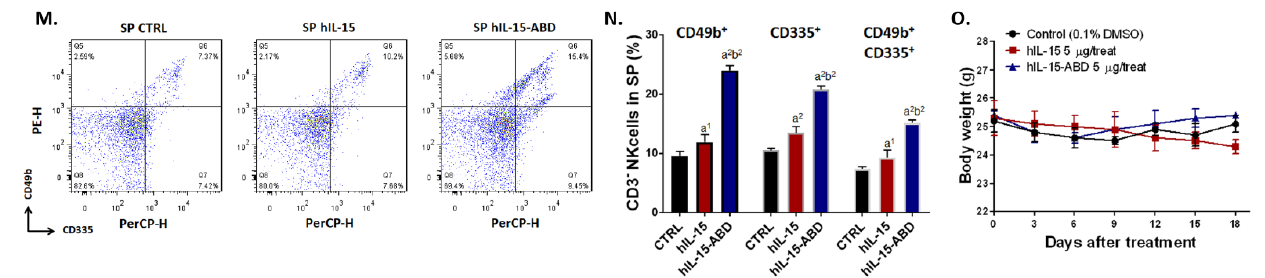
Figure 3. hIL15-ABD induced the accumulation of CD8 + T cells and NK cells, but diminished Tregs and MDSCs, resulting in colon cancer growth inhibition. ( A ) Animal flow chart of different treatment materials is displayed. ( B ) Tumor volume is recorded every 3 days and ( C ) tumor weight is weighed after isolation from mice on day 21. ( D ) Flow cytometry pattern of CD11b+/Gr-1+ MDSCs isolated from BM and SP. Percentage of CD11b + /Gr-1 + MDSCs from ( E ) BM and ( F ) SP are gated and quantified by FlowJo software. ( G ) Flow cytometry pattern of CD4+/CD25+/FOXP+ Tregs isolated from TDLN and SP. Percentage of CD4 + /CD25 + /FOXP3 + Tregs from ( H ) TDLN and ( I ) SP. ( J ) Flow cytometry pattern of CD8 + T cells isolated from TDLN and SP. Percentage of CD8 + T cells from ( K ) TDLN and ( L ) SP. ( M ) Flow cytometry pattern of CD3 - /CD49b + /CD335 + NK cells isolated from TDLN and SP. Percentage of CD3 - /CD49b + /CD335 + NK cells from ( N ) SP. ( O ) Mice body weight are measured 3 time per week. [BM = bone marrow, TDLN = tumor-draining lymph node and SP = spleen] (a 1 p < 0.05, a 2 p < 0.01 vs. CTRL; b 1 p < 0.05, b 2 p < 0.01 vs. hIL15).